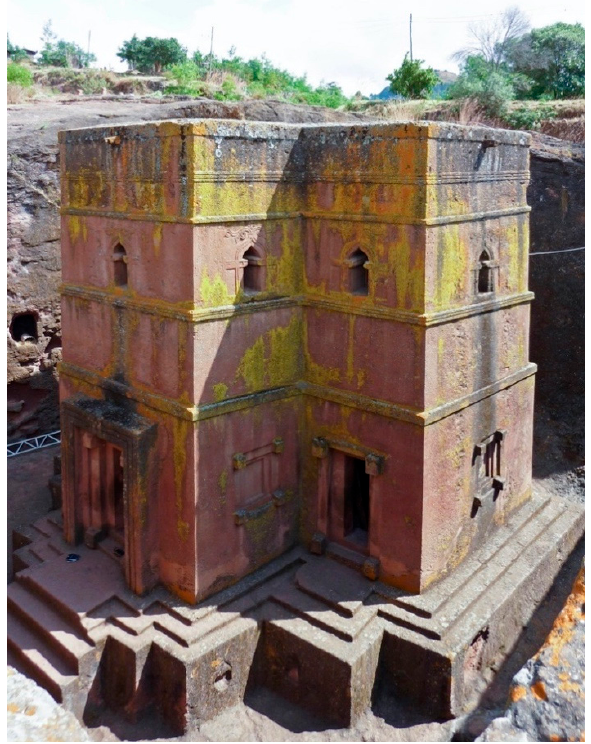
Figure 12. Bete Giyorgis (St. George), one of the rock-hewn churches of Lalibela, Ethiopia, is home to a bee colony said to have begun in 900 CE.